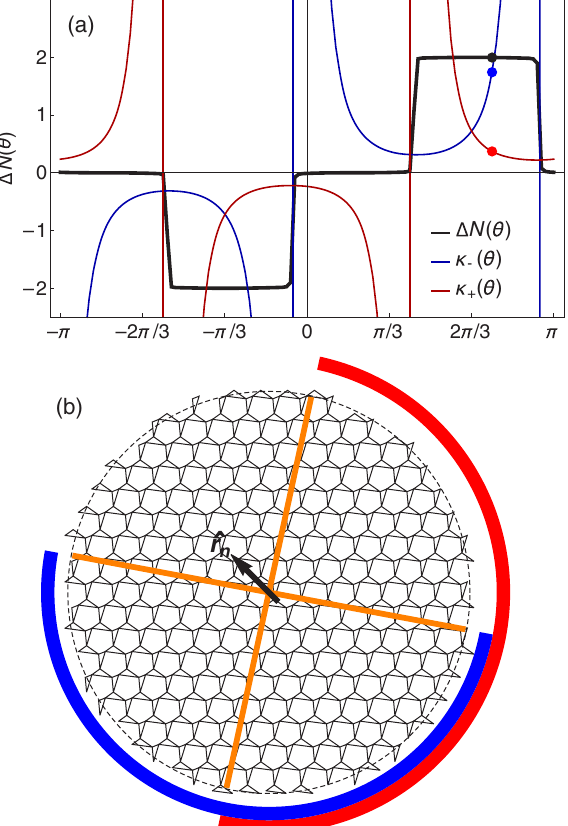
FIG. 5. (a) For a fixed system, we numerically compute the ; κ signed inverse decay lengths of each mode [ κ − ð θ ð θ n Þ ] and ≡ ˆ q n Þ þ · q , and the component q n n t the topological polarization Δ N ð θ as a function of the normal n Þ ˆ x þ cos θ ˆ y . ð θ Þ ≡ − sin θ θ direction ˆ r . (b) The polarization changes as the considered n n n t n ð n Þ direction crosses either soft direction (orange lines). One can then find the regions of the lattice where the þ or − edge modes are located (blue or red